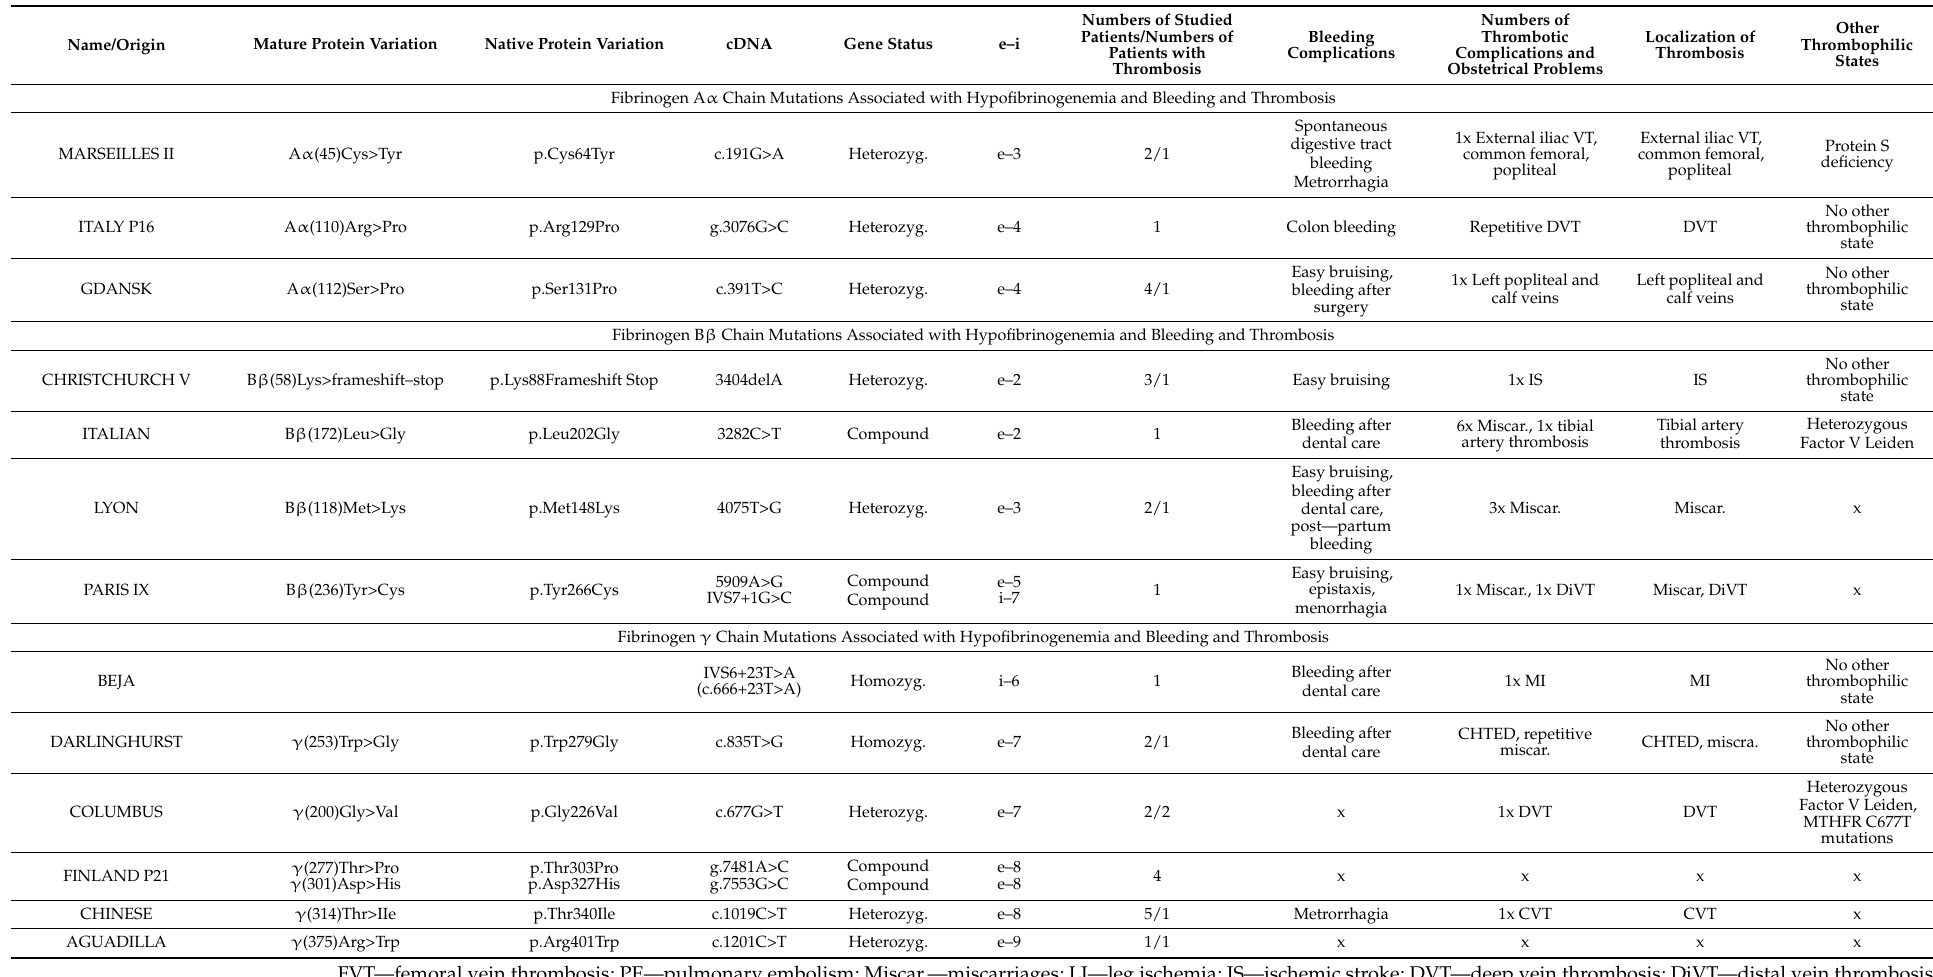
Table 2. Description of clinical studies and fibrinogen mutations in congenital hypofibrinogenemia associated with bleeding and thrombotic manifestations